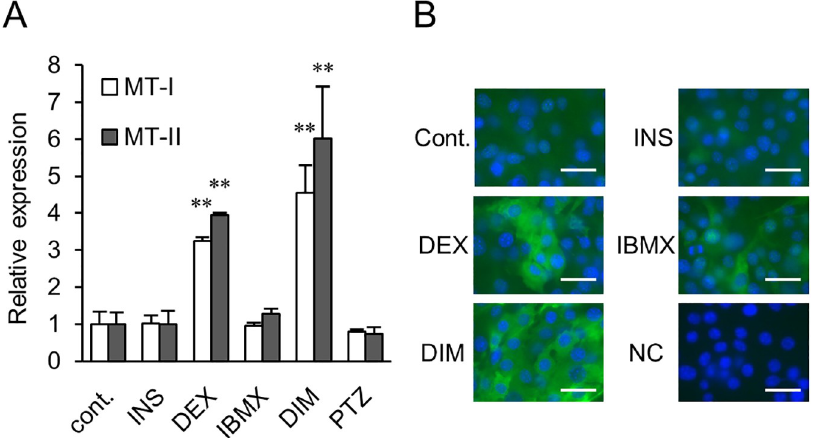
Fig 5. Effect of standard DIM and three separatecomponents on MT expression. 3T3-L1 preadipocytes were treated with DIM or three componentsseparately (1 μ g/ml insulin(INS), 1 μ M DEX, and 0.5 mM IBMX). A thiazolidinedione,i.e., pioglitazone (PTZ), was also used at a concentration of 1 μ M. (A) The expression levels of mt1 mRNA (open columns) and mt2 mRNA (filled columns) are shown as percentagesrelative to the cells cultured in DMEM + 10% FBS (cont.). Data are expressedas the mean ± SD ( n = 3). ** P < 0.01, comparedwith the control cells. (B) The expressions of the MT proteinswere detected using anti-MT1 and MT2 total proteinsfollowedby Alexa Fluor 488-conjugatedsecondary antibody(Green). Negativecontrol (NC); stainingwithout the primary antibody. Nuclei were stainedwith Hoechst 33258 (blue). Bar = 40 μ m.